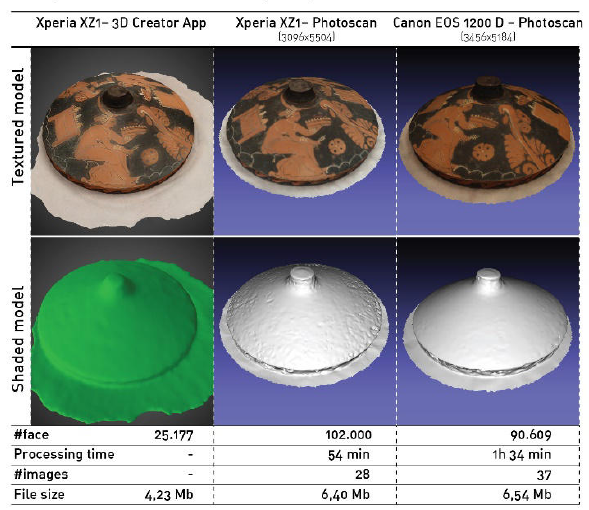
Figure 11. Comparative assessment-matrix on Alexander the Great The interval range has been set from 0.00 to 0.005 m.